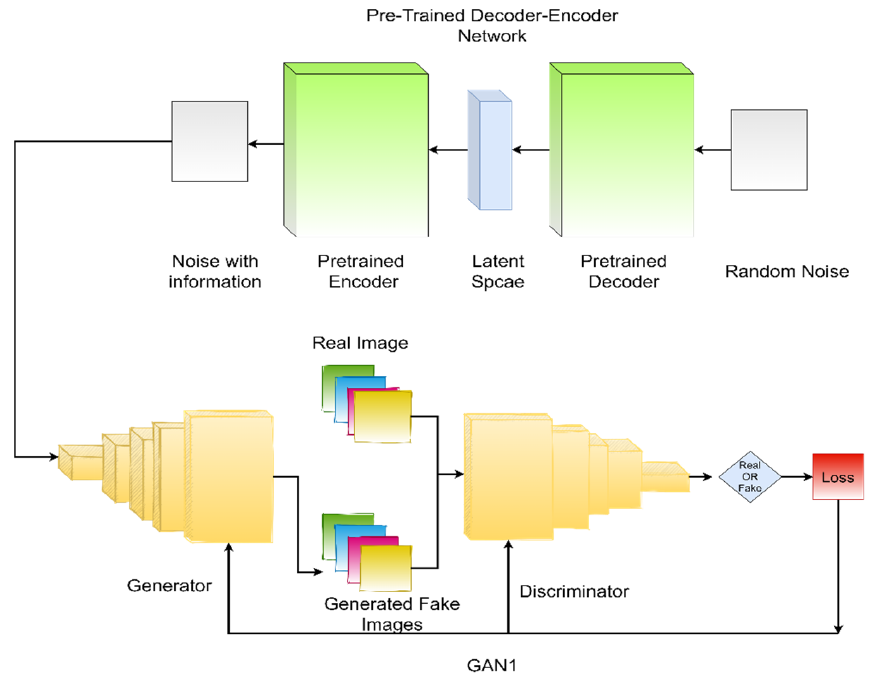
Figure 1. Encoder-decoder of VAE is swapped after the training so that output noise from the decoder could be used as an input to the generator of GAN 1 . The figure represents the VAE and the GAN 1 of the proposed methodology. It’s a partial block diagram representation of the proposed TED-GAN.